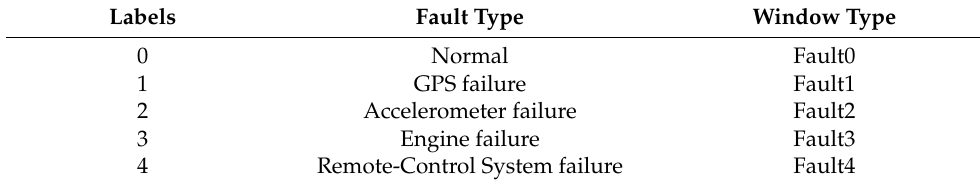
Table 6. Fault types represented by class labels.